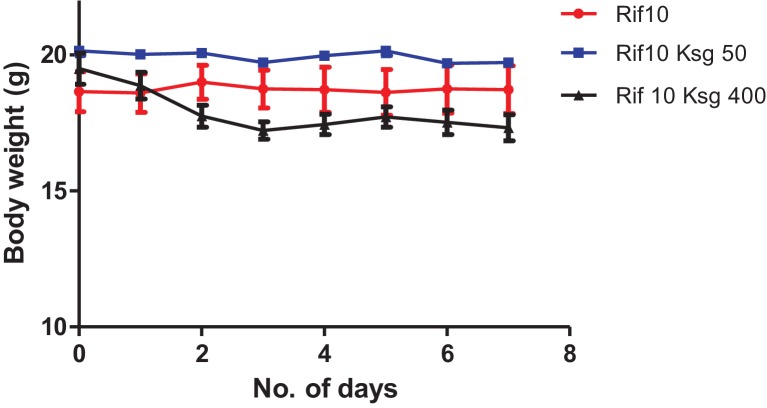
Kasugamycin-rifampicin co-administration is toxic to mice at high doses.Mice were given ksg (intra-peritoneal injection) and rifampicin (oral gavage) daily at the indicated doses. Weight was measured daily.